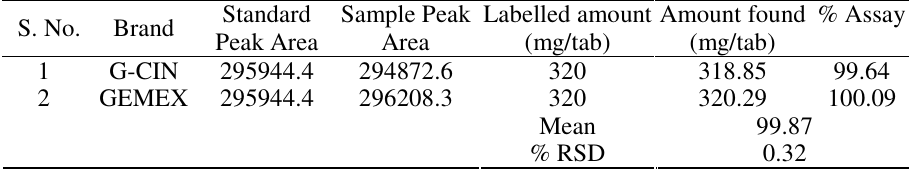
Table 2. Results of assay in marketed formulation